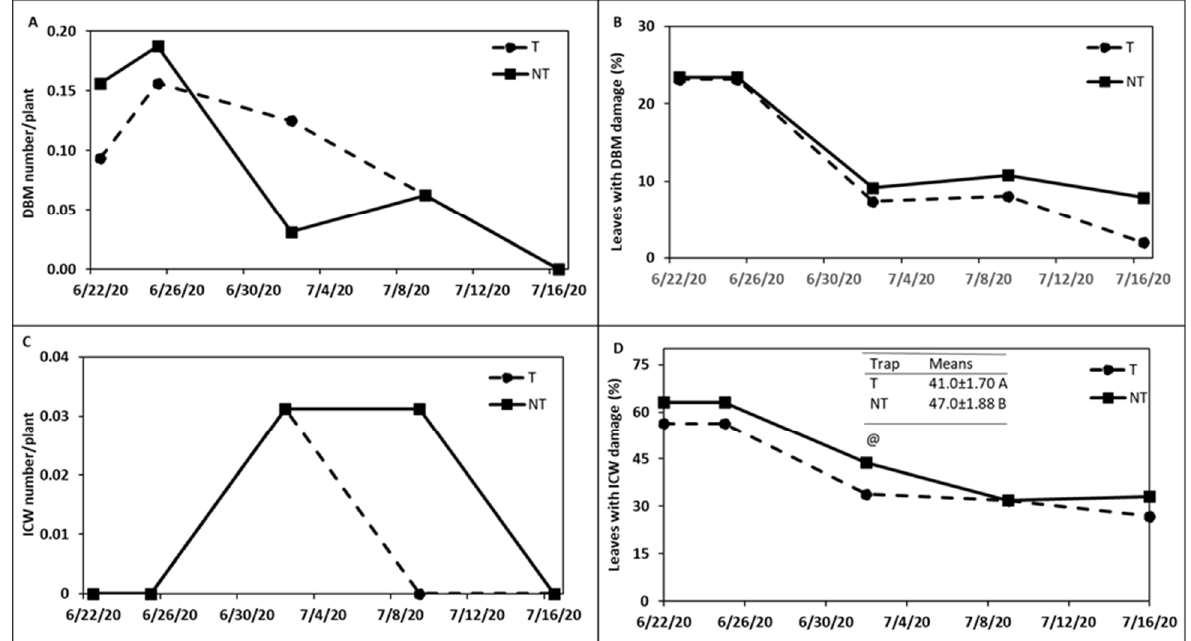
Figure 14. Effects of kai choi as a trap crop on ( A ) Abundance of DBM; ( B ) Percentage of leaves with DBM damage; ( C ) Abundance of ICW; ( D ) Percentage of leaves with ICW damage on kale in Trial II. T = Trap crop, NT = No trap crop. Means followed by the same letter are not different based on analysis of variance. @ indicates di ff erences between EPN+ and EPN − at p ≤ 0.10 level.